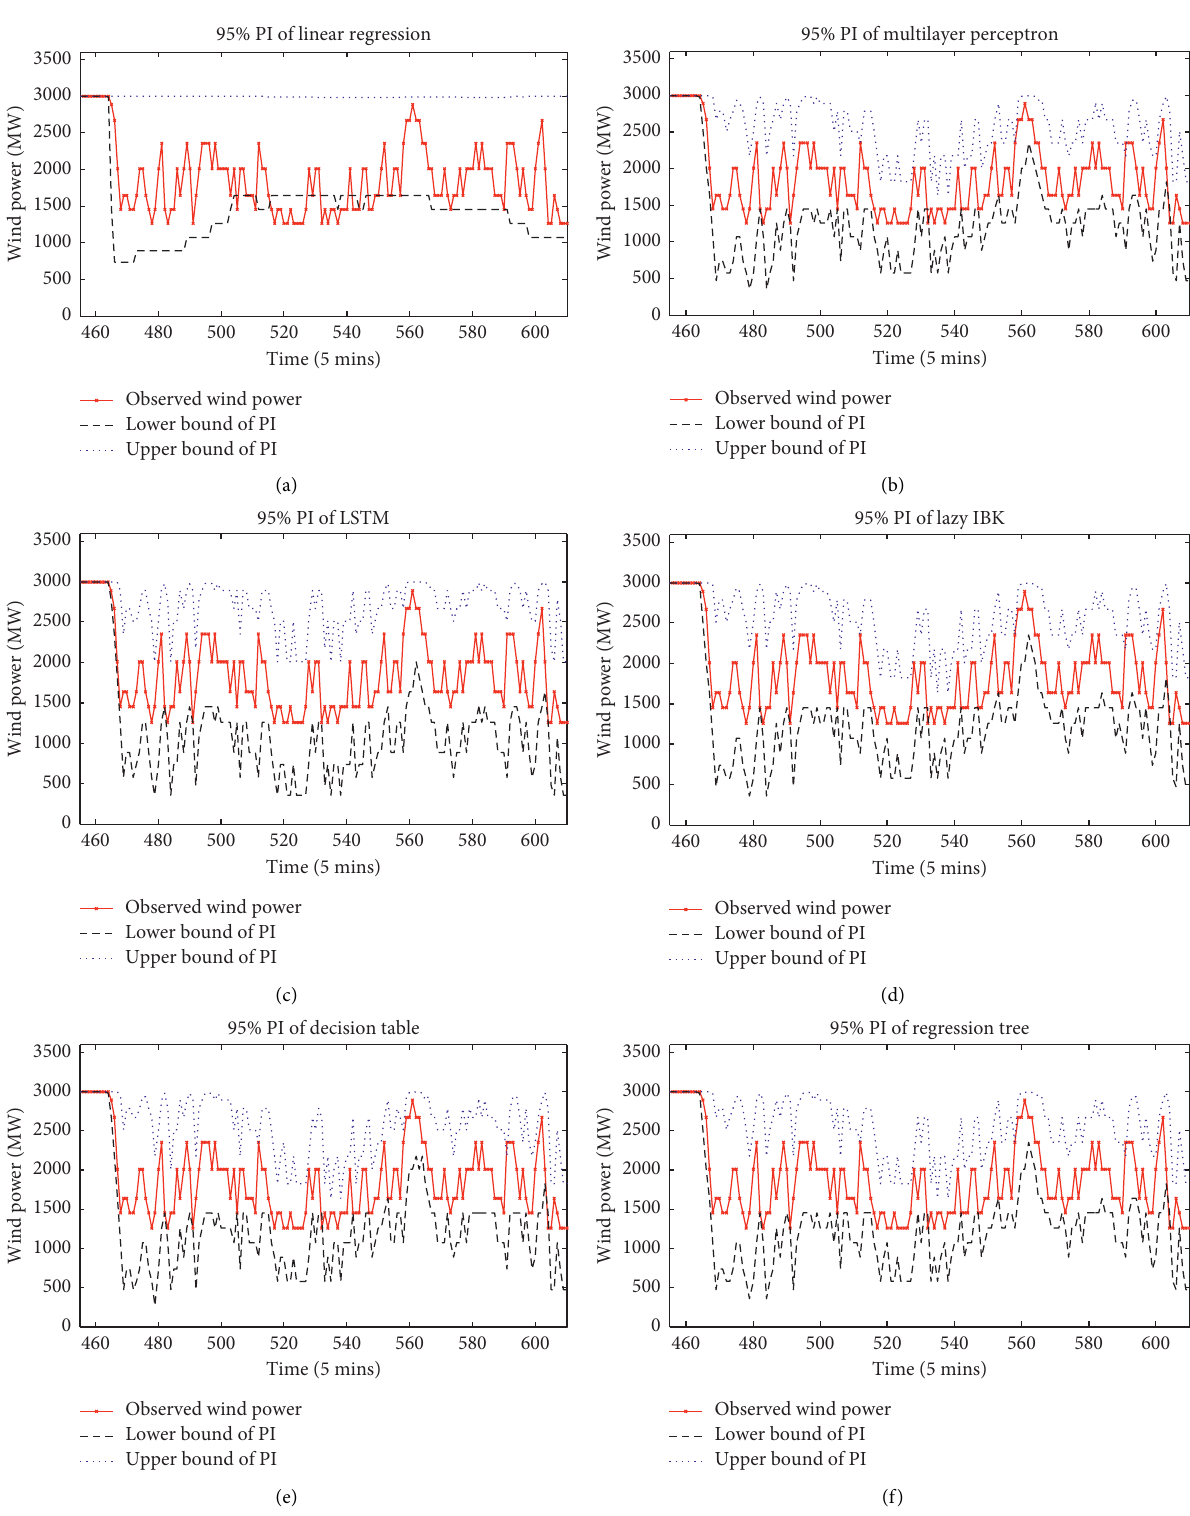
Figure 6: 95% level prediction intervals forecasted by six machine learning regression